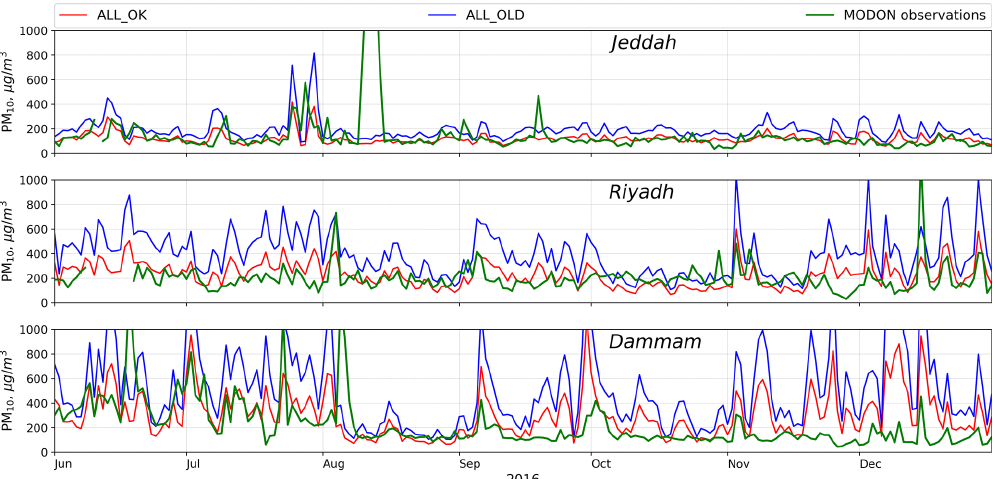
Figure 8. Daily averaged PM 10 surface concentrations (µgm − 3 ) from the ALL_OK and ALL_OLD runs (red and blue lines) and from MODON observations (green line) at Jeddah, Riyadh, and Dammam.